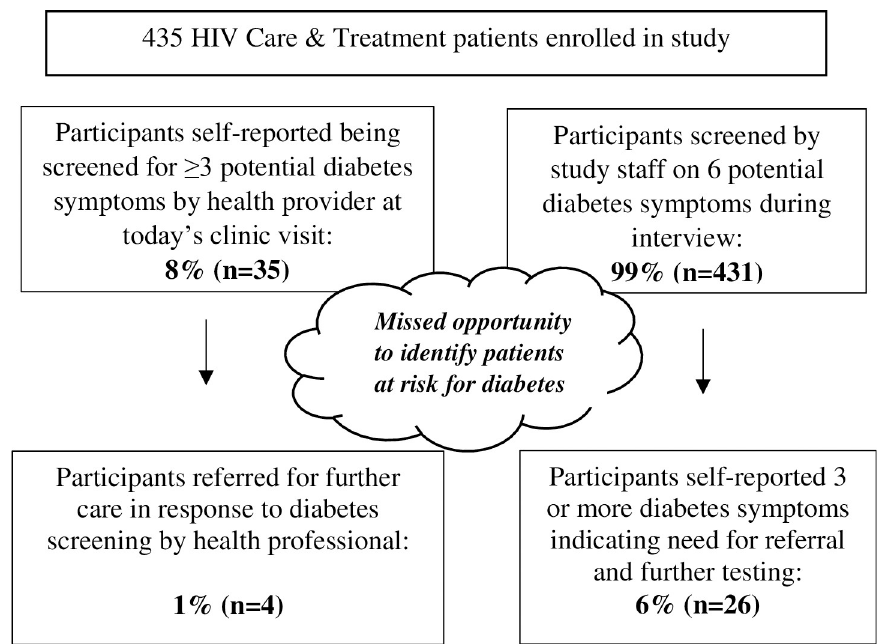
Fig 1. Integration of diabetes screening and referral within HIV care and treatment